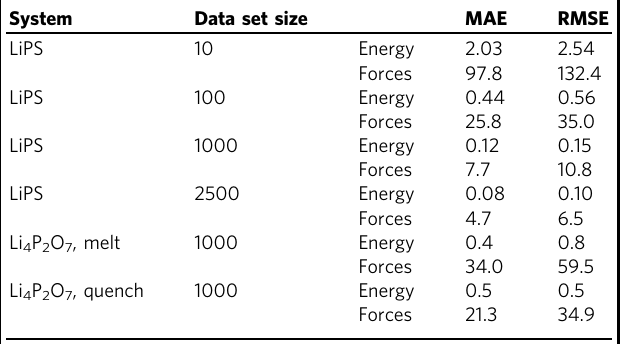
The model for Li 4 P 2 O 7 was trained exclusively on structures from the melted trajectory. The reported test errors for the melt are computed on the remaining set of structures from the full melt trajectory; errors for the quench are computed on the full quench trajectory.